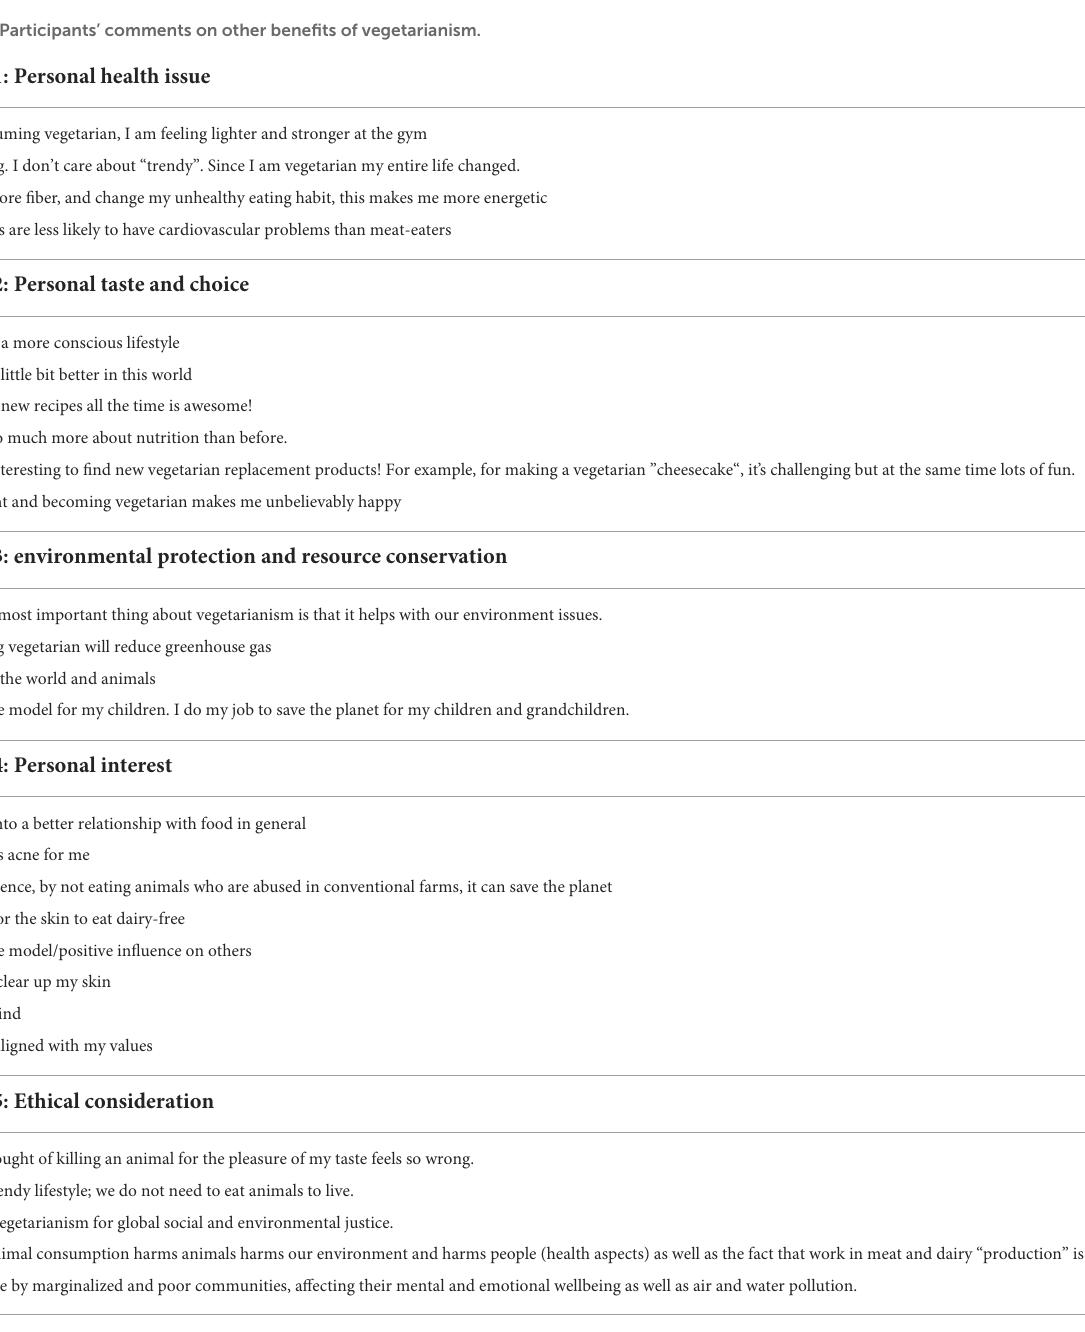
TABLE 6 Participants’ comments on other benefits of